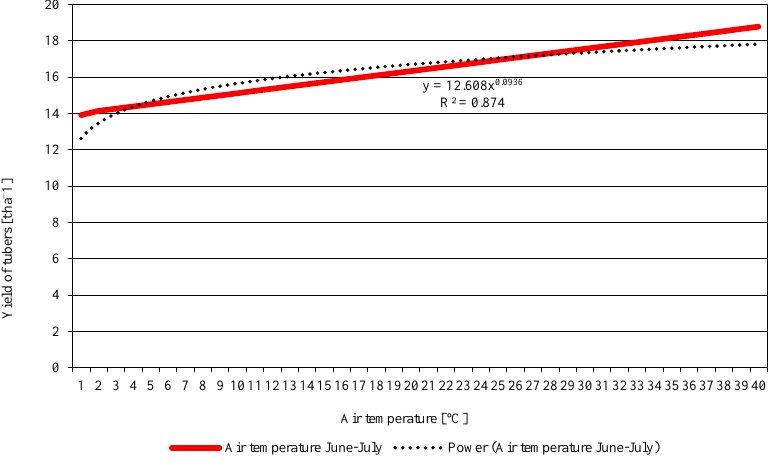
Figure 6. Partial dependence of tuber yield on air temperature in the June – July period. The results of the regression analysis of the yield with air temperature in the second part of the growing season (August – September) are described by the formula in Figure 7. As a result of the air temperature increase in this period of time, there was a systematic decrease in yield value. The value of the coefficient of determination, amounting to 84.67%, makes the equation highly reliable [19]. Figure 7. Partial dependence and potato tuber yield on air temperature in August – September. 3.6. Influence of Precipitation on the Formation of Tuber Yield The factor used to assess the influence of meteorological conditions on potato yielding was also the sum of atmospheric precipitation. Among the periods in which their impact on the variability of potato yielding was the most frequent, the rainfall in the April – May period turned out to be the most impactful. The regression model described by the following equation.